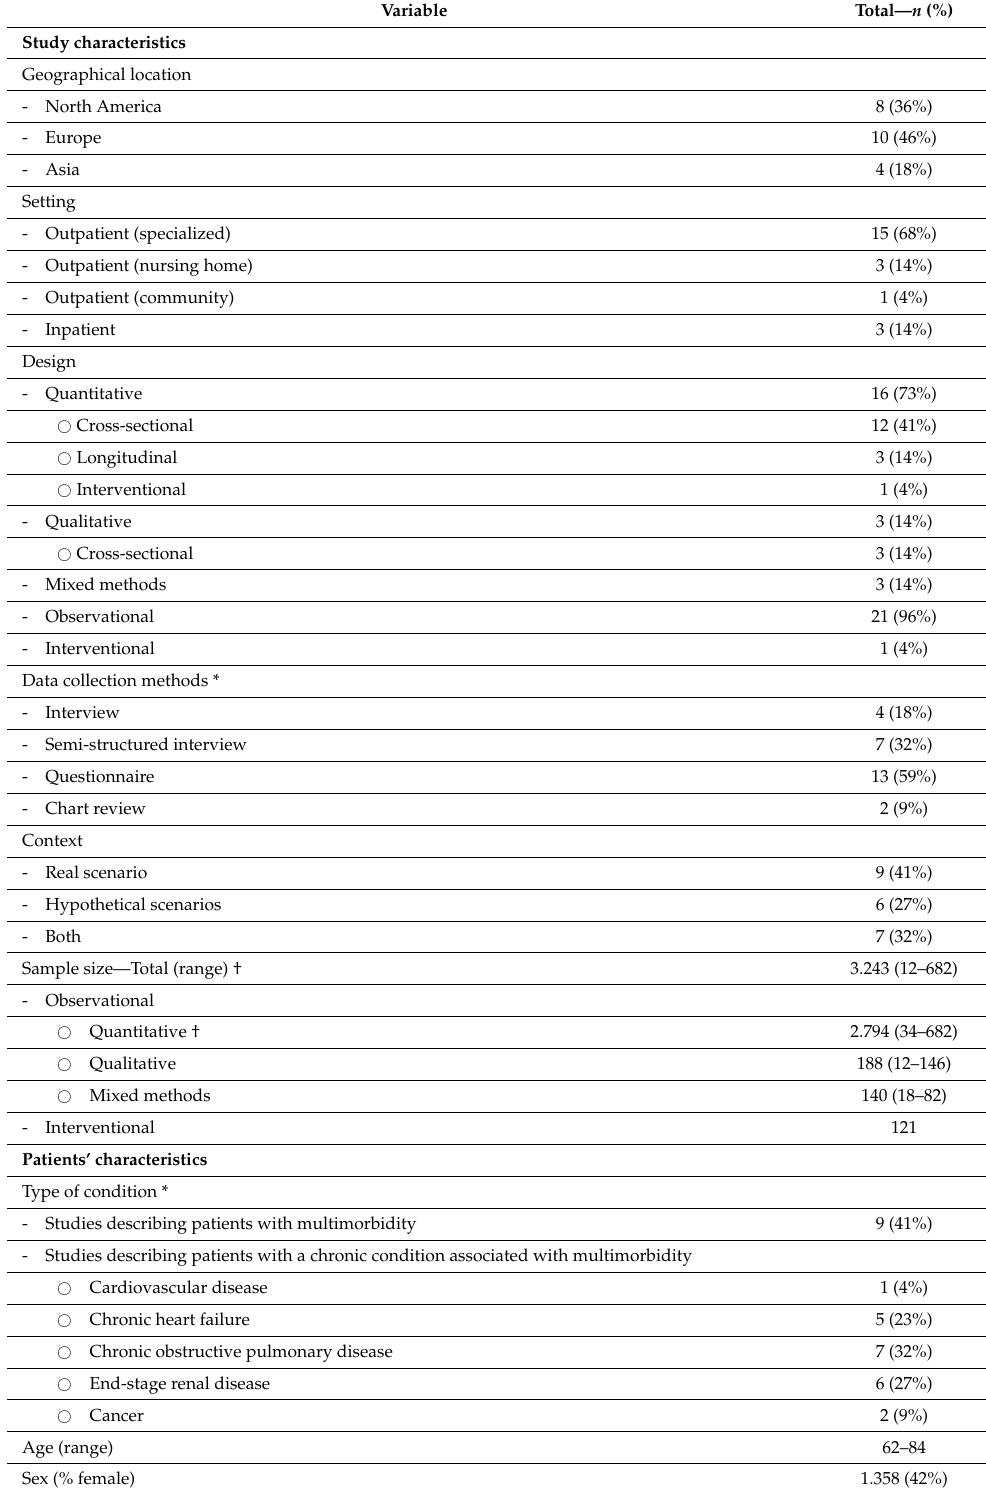
Table 2. Descriptive summary of included